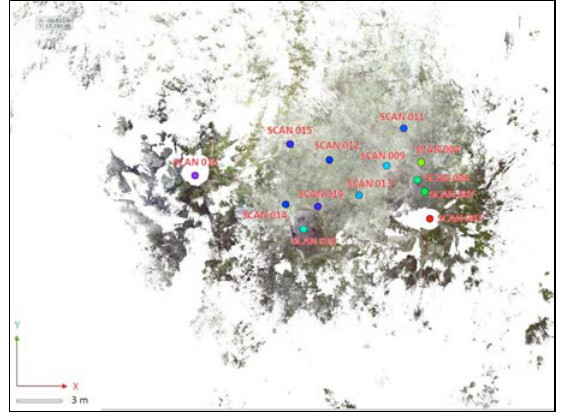
Figure 4. Layout the 13 laser scanning stations distributed on the Grotta Scritta site (top view). Grotta1 (rock overhang): scans 004, 006 and 007. Grotta2: scans 012, 014 and